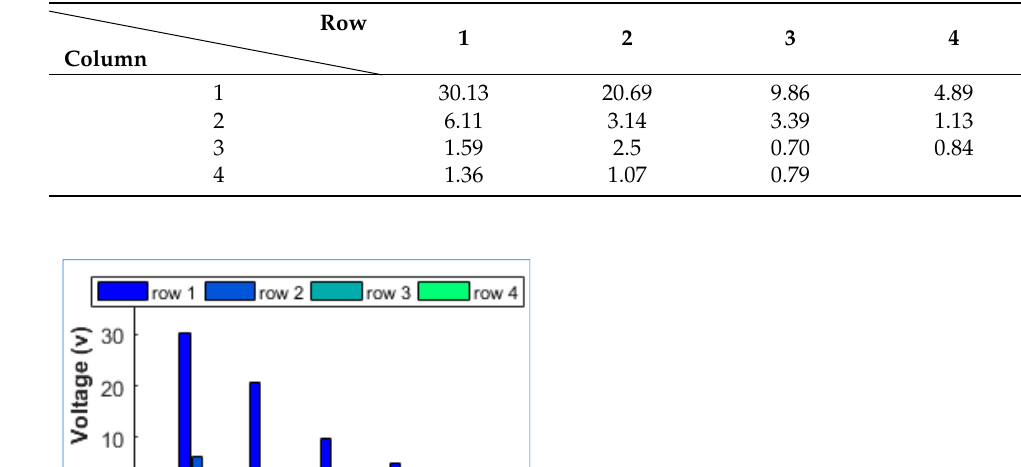
Table 2. Value of the voltage output of each block/grid according to the scale factor.